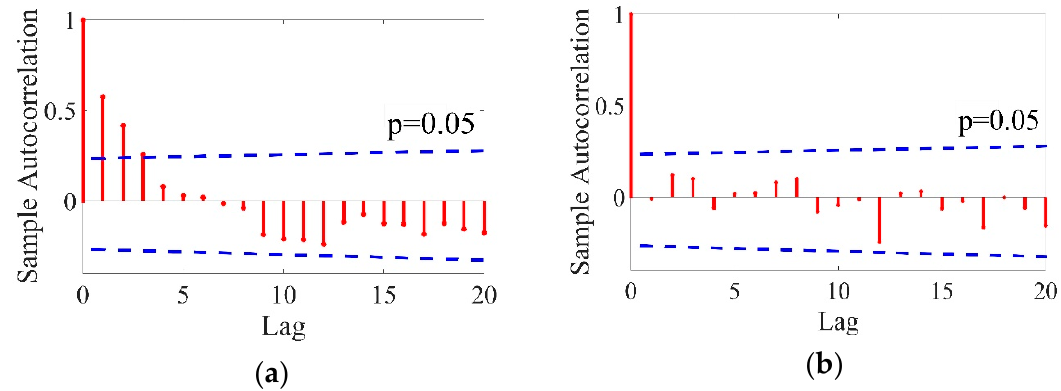
Figure 4. Model diagnostic on the ( a ) original minimum one-day flow and ( b ) pre-whitened minimum 1-day flow by an estimated autocorrelation function (ACF).